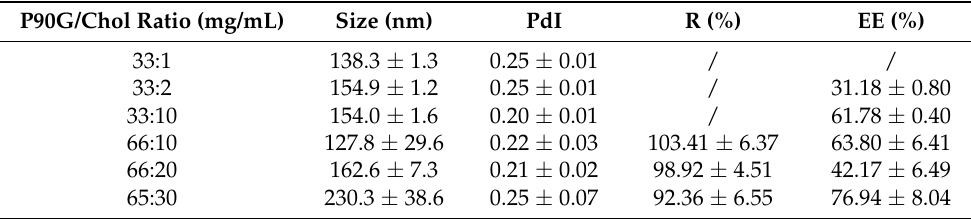
Table 3. Physical characterization in terms of size, PdI, and ζ -potential of BRB-L. All results are expressed as mean ± SD ( n = 3).